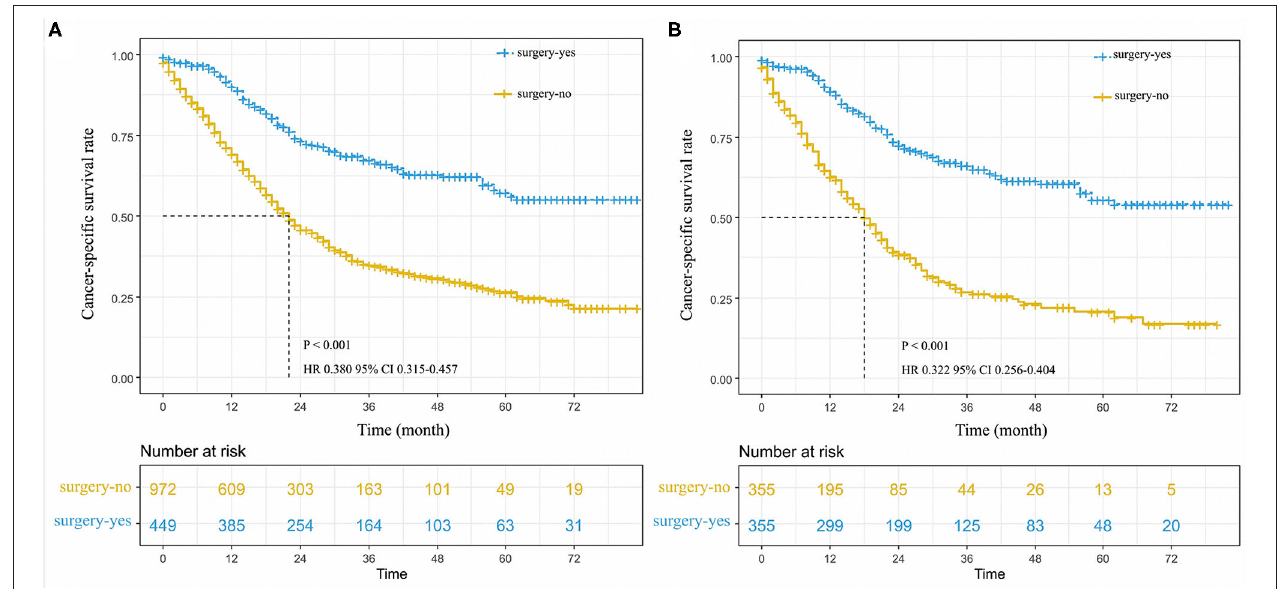
FIGURE 1 | Cancer-specific survival curve for stage I-IIA small cell lung cancer patients with according to the treatment approach in the unmatched cohort (A) , and matched patients (B) . and IB ( N = 285, 20.1%). In this cohort, the tumor was Within the cohort, the number of patients who received located in the upper lobe in some patients ( N = 833, 58.6%) surgery was 449 (31.6%); the remaining patients were 972 and in the lower lobe in others ( N = 410, 28.9%). Among (68.4%) (without surgery) ( Table 1 ). The main (pathological the degrees of tumor differentiation, there were 11 tumor node metastasis) pTNM stage was IA ( N = 951, 66.9%)